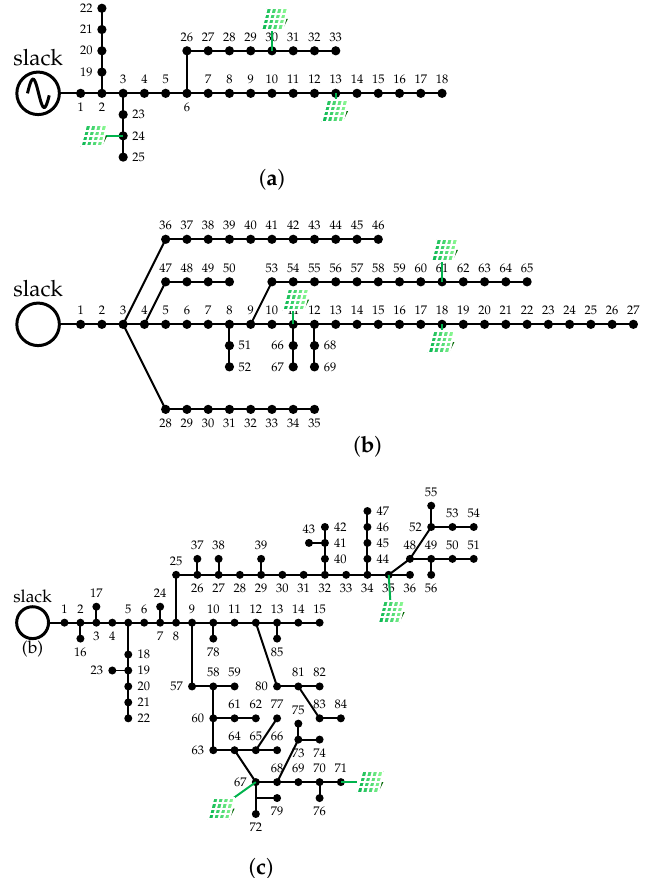
Figure 2. Test system diagrams: ( a ) modified IEEE 33-bus test system; ( b ) modified IEEE 69-bus test system; and ( c ) modified IEEE 85-bus test